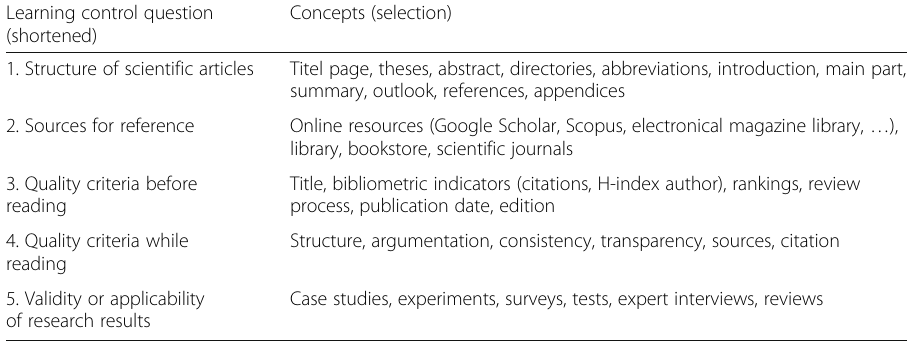
Table 1 Concepts for coding the answers to learning control questions Learning control question